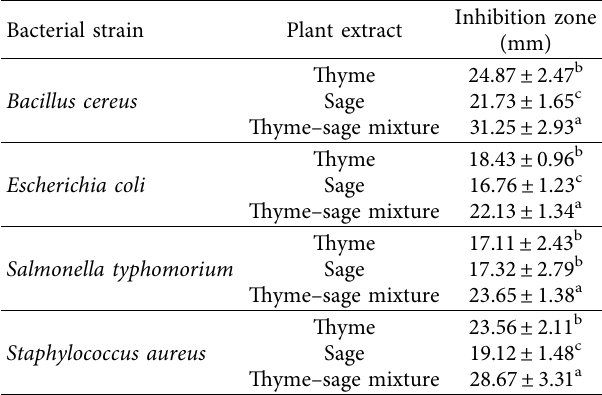
Table 4: Te mean ± SD of antimicrobial activity of sage, thyme, and thyme–sage mixture extracts against E. coli, S. aureus, B. cereus , and S. typhomorium